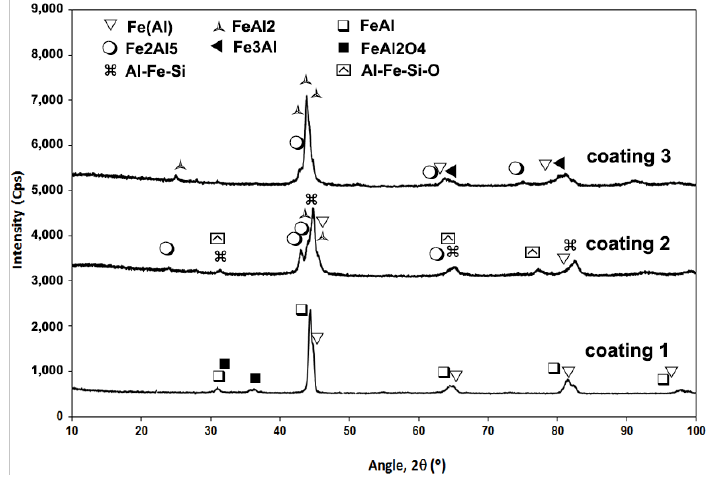
Figure 5. X-ray diffraction of the as-sprayed coatings.